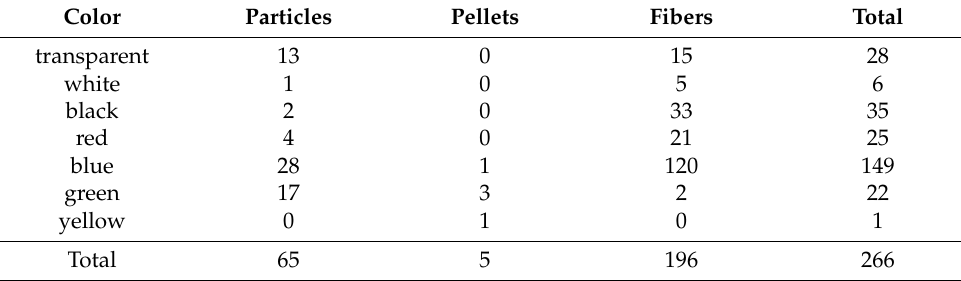
Figure 6. Percentage contribution of dominating colors of MPs for fibers ( a ), pellets ( b ), and parti-